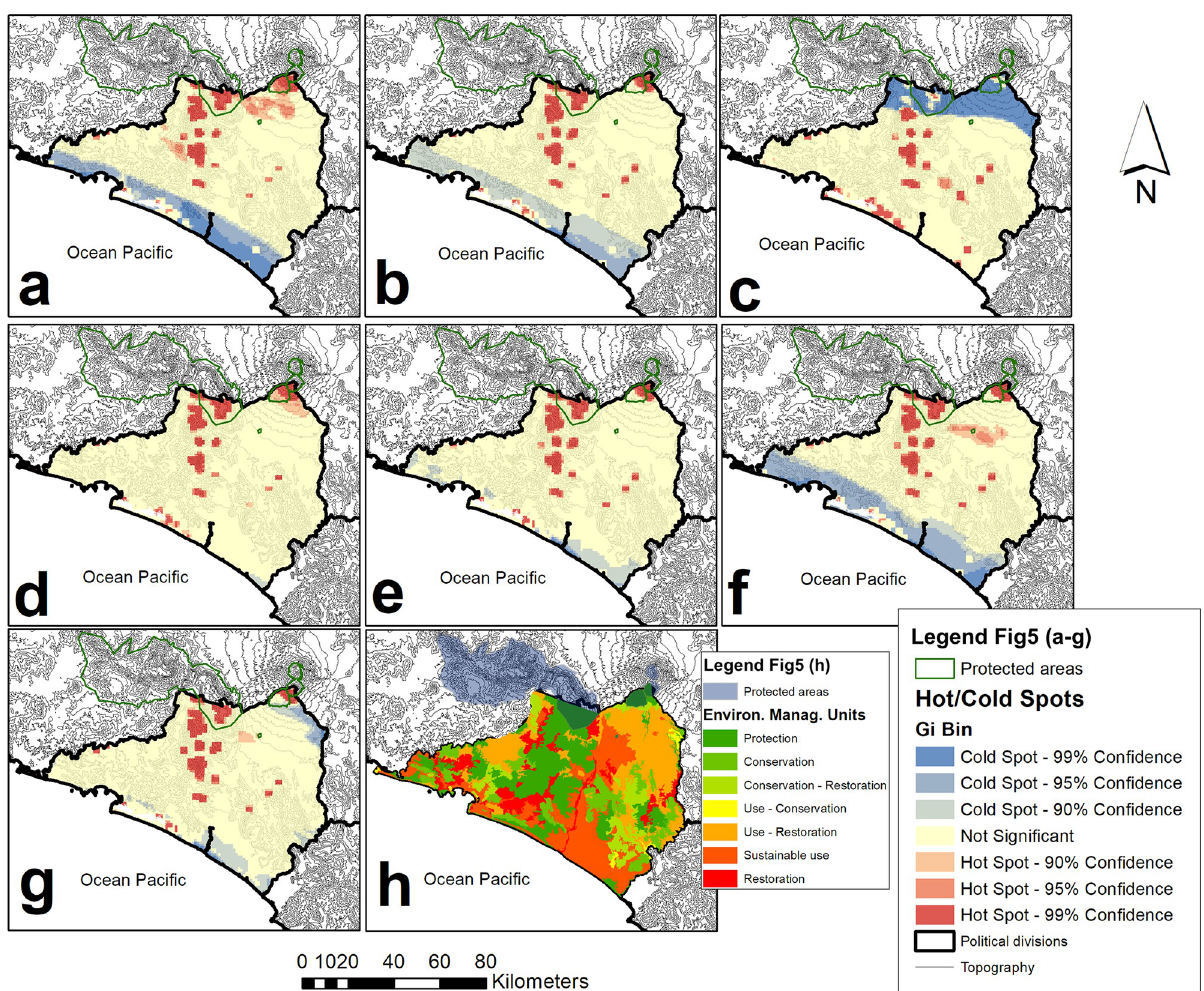
Fig 6. Statistically significant hot spots identified for: (a) amphibians; b) birds; c) reptiles; d) mammals; e) all vertebrate species; f) endemic species; g) threatened species in Colima, Mexico; and h) Environmental Management Units determined by the ecological territorial ordering for Colima. Maps were created by J.F.G.M. using ArcGIS 10.2.1. software